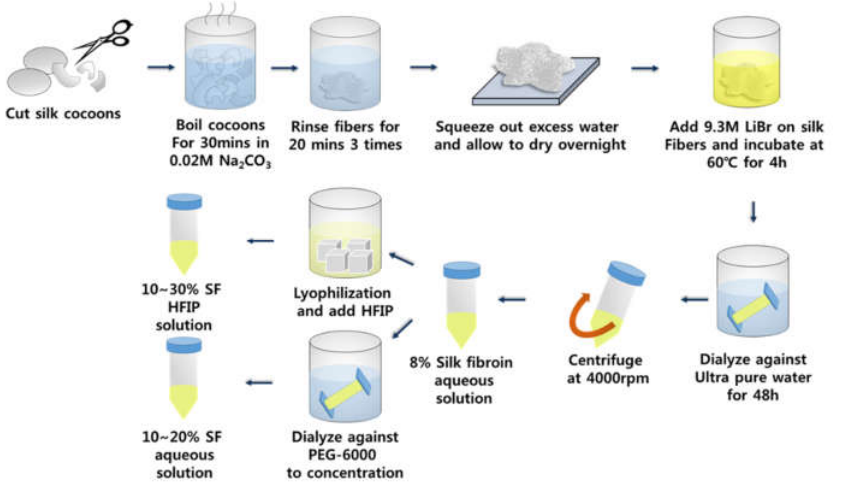
Figure 1. A schematic diagram of SF solution preparation.